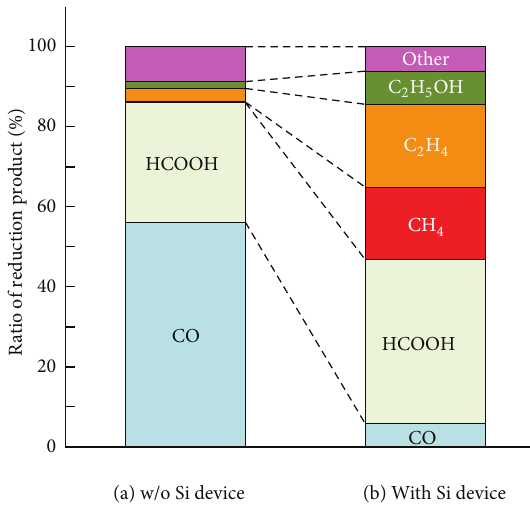
Figure 3: Ratio of products in the photoelectrochemical CO 2 reduction under 8-SUN: (a) without the Si device; (b) with Si device.